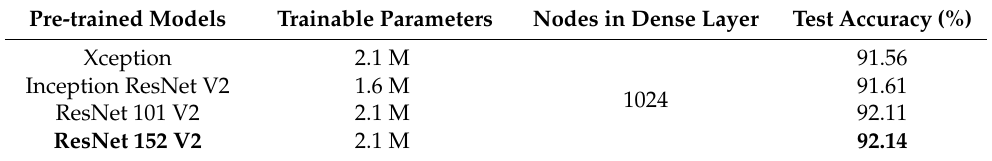
Figure 10. Example of augmentation techniques: ( a ) original image; ( b ) width shift by 20%; ( c ) height shift by 20%; ( d ) rotation by 25 degree; ( e ) shearing by 20%; ( f ) horizontal flip. Table 2. Comparison of the pretrained models on the RAP v2 Dataset.